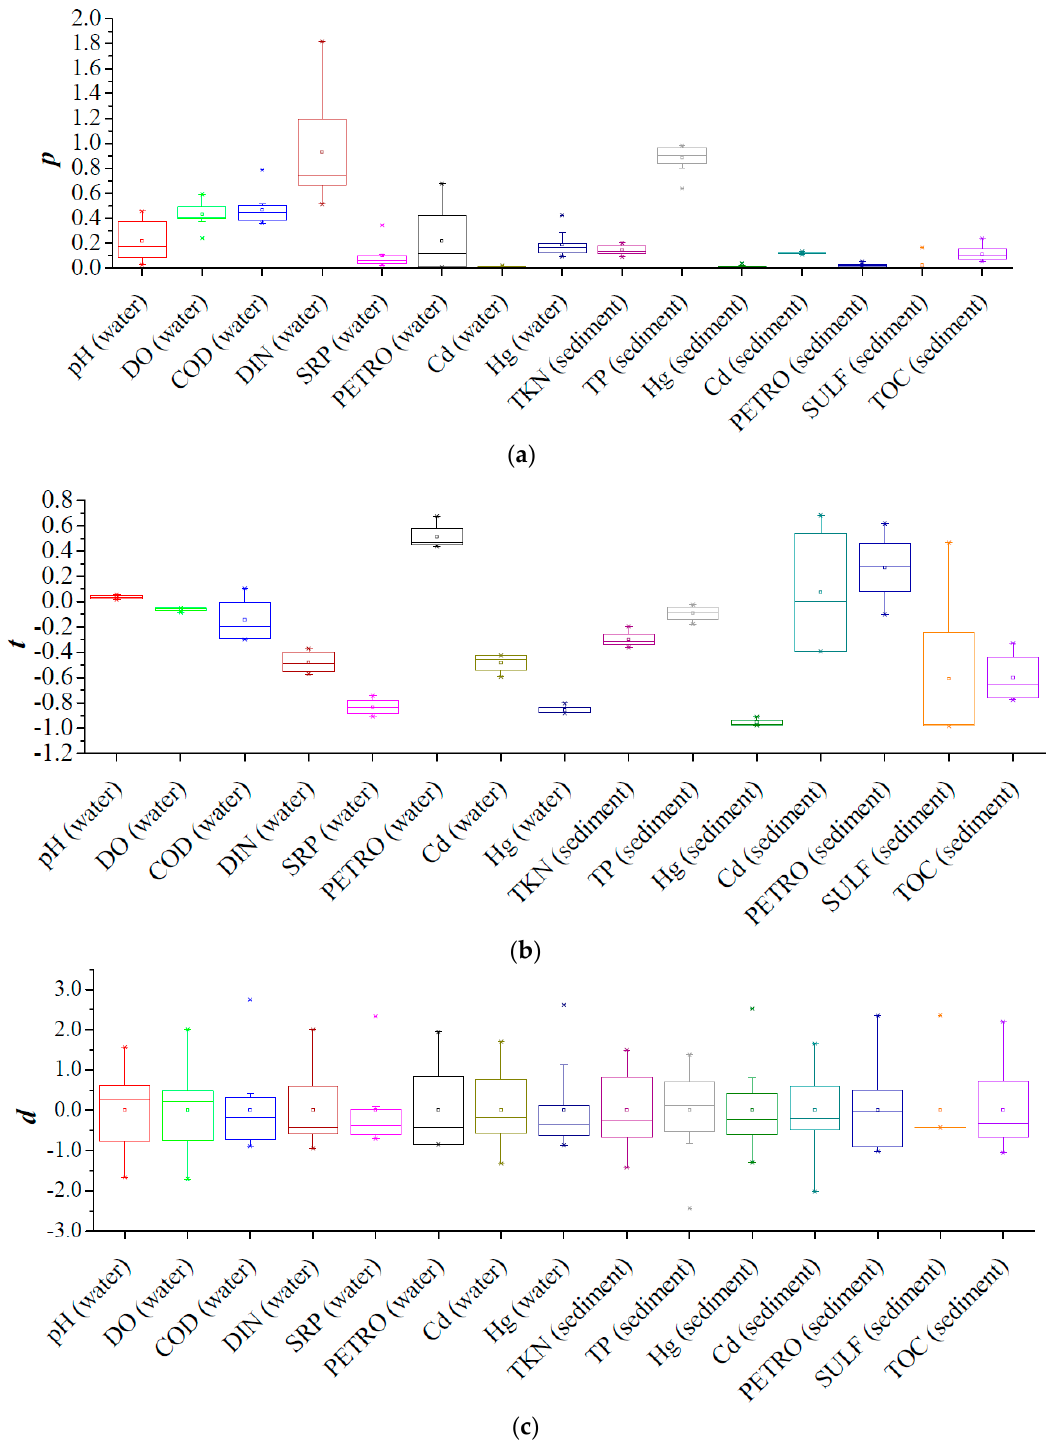
Figure 7. The box charts of ( a ) pollution status; ( b ) temporal variation; and, ( c ) spatial variation of the variable measurements.